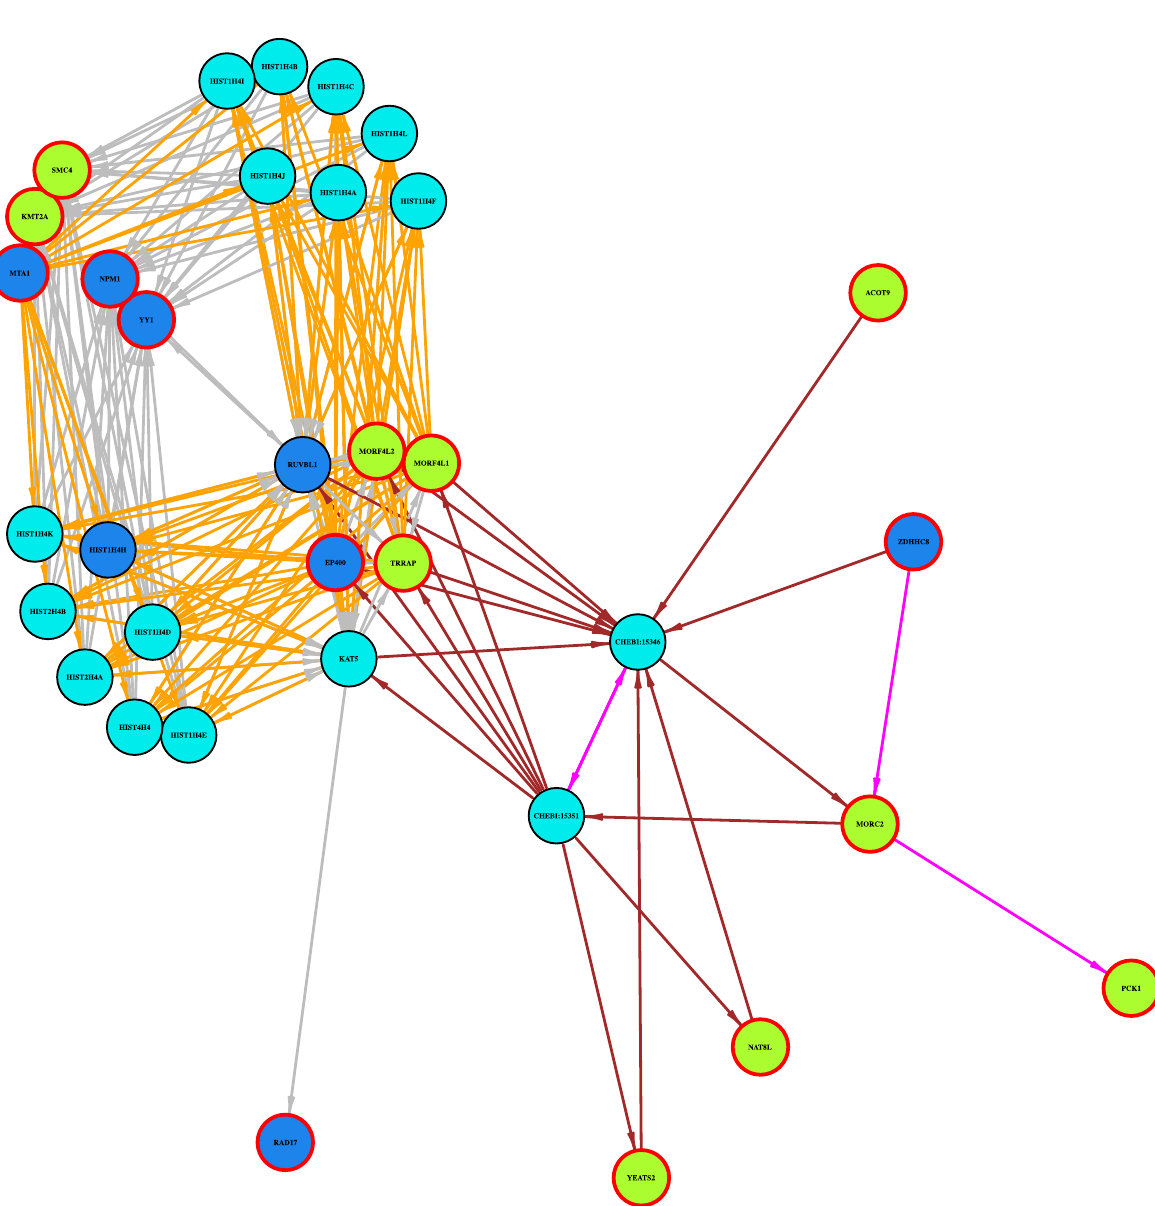
Fig 5. POGZ: Formation of the beta-catenin:TCF transactivating complex. Simplified diagram of the pathway ‘Formation of the beta-catenin: TCF transactivating complex’ as enriched in the target list of the gene POGZ. Applying the less stringent criterion for a regulator to be the best regulator of targets. Nodes: Green = significant target, Red border = regulator is best regulator for target Dark Blue = enriched centre also significant target, Light Blue = enriched centre but not significant target. Edges: grey = ‘in-complex-with’, purple = ‘catalysis-precedes’, ‘used-to-produce’ orange = ‘controls-state-change-of’, ‘controls-phosphorylation-of’ brown = ‘controls-expression-of’, ‘cntrls-production-of’, consumption-cntrlled- by’.